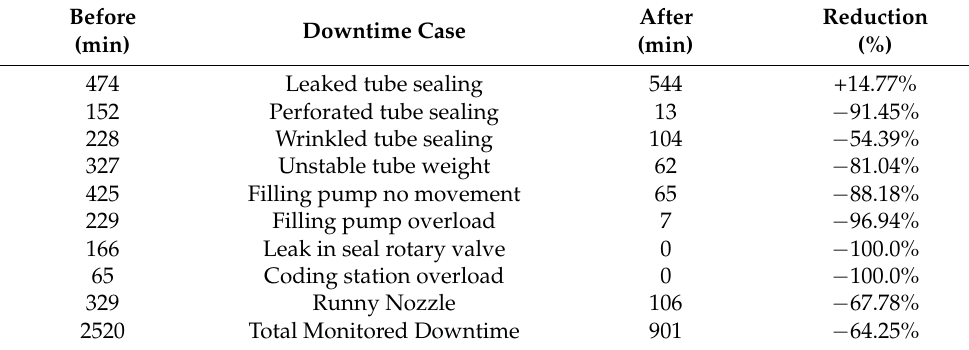
Table 11. The effectiveness of downtime reduction in system